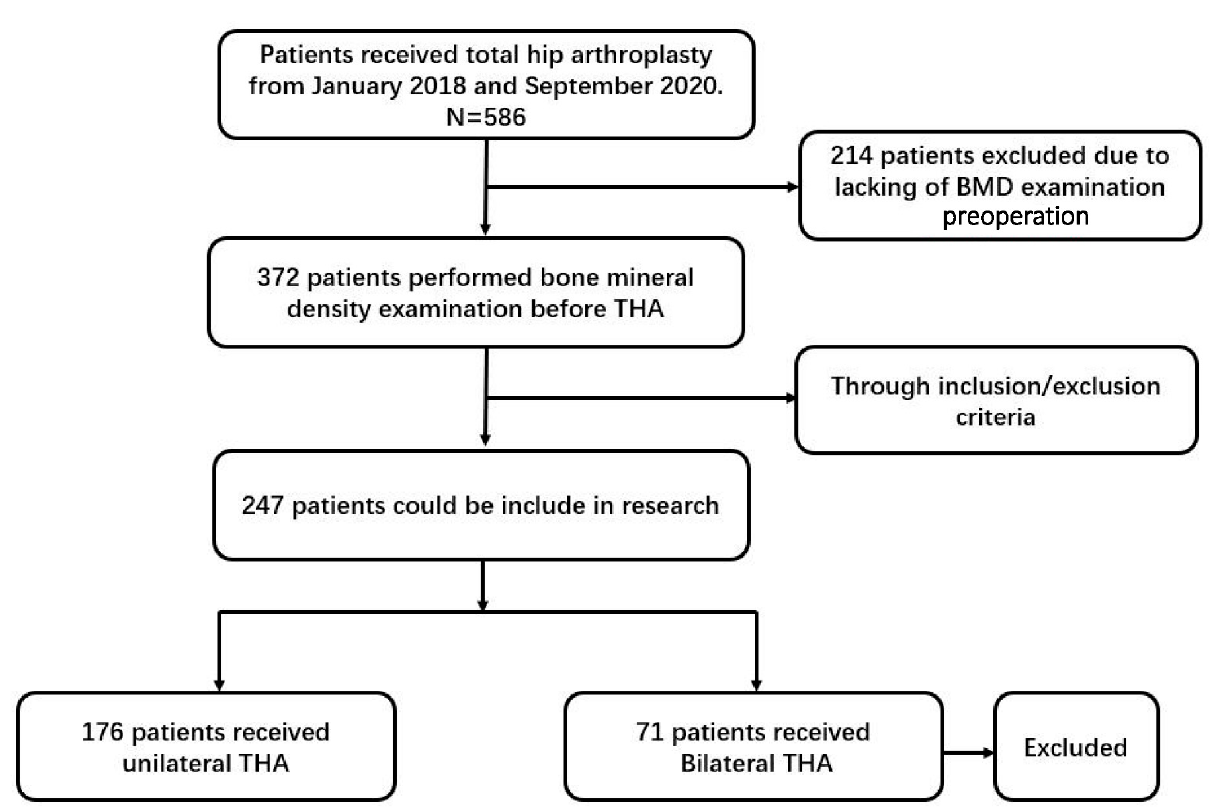
Figure 1. Study flow of this research. BMD is bone mineral density. THA is total hip arthroplasty.